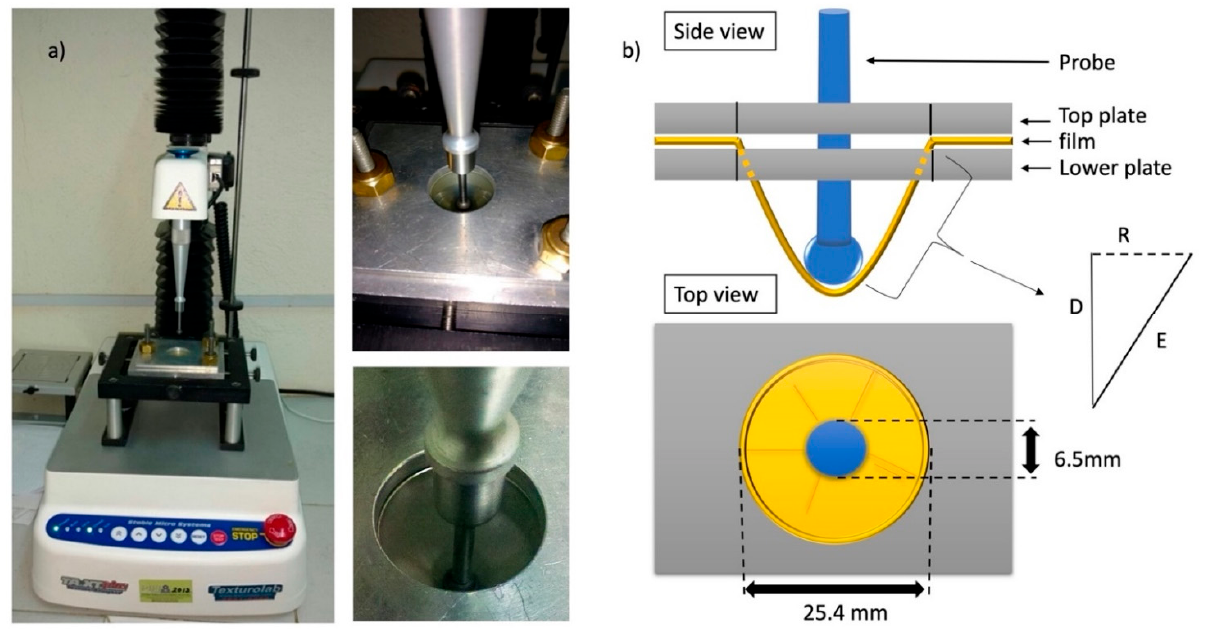
Figure 4 . Schematic diagram of the texture analyzer used for compression test for film. The texture analyzer ( a ) consisted of a probe and a support. ( b ) System for measuring the elongation of composite films. D: maximum penetration distance of the probe before rupture (mm). R: radius of circumference of the plate (12.7 mm). E: elongation (mm) of the film [73].